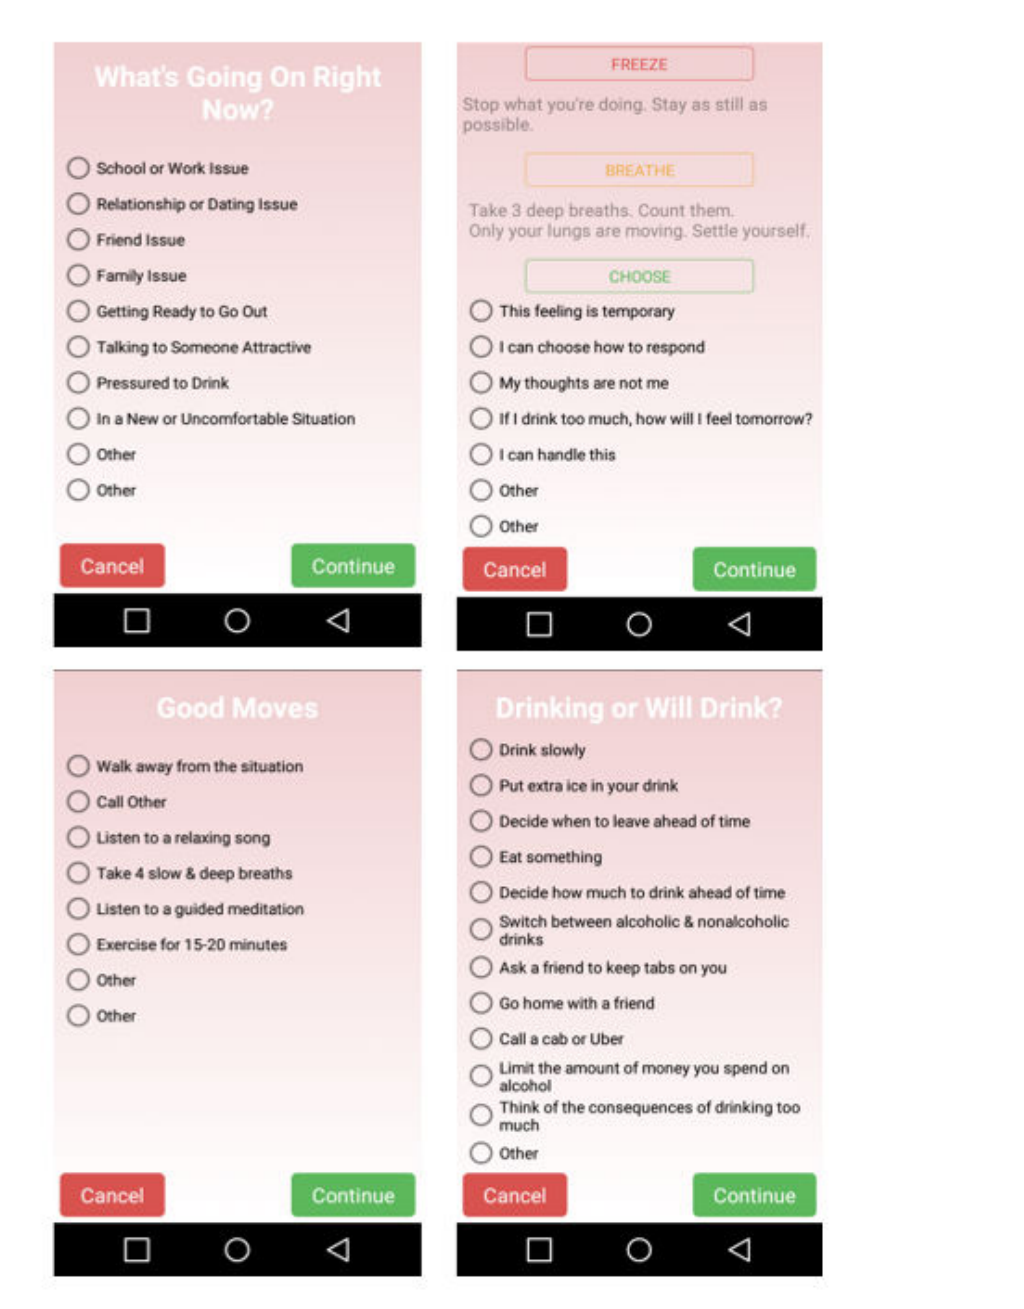
Figure 3. MtM app